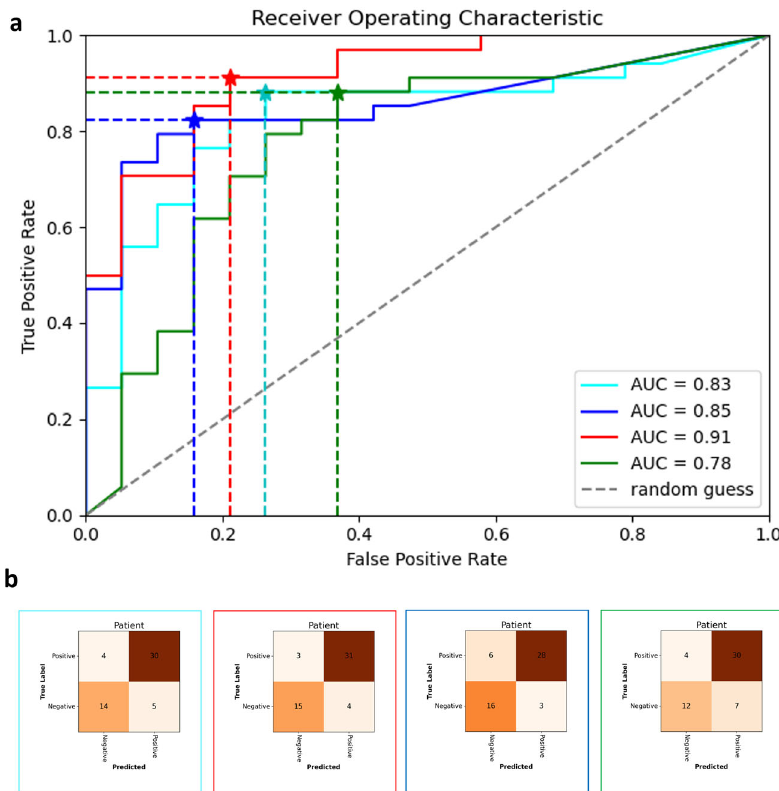
Fig. 3 Evaluation results for ESV1 on patient level. Receiver operator characteristics on EVS1 resulting from fourfold cross validation ( a ). Confusion matrices are shown in ( b ) for the optimal threshold (* in ( a )) in each fold. Frame colours in ( b ) correspond to ROC fold colours in ( a )). Vessel status is extracted automatically from 53 patients in EVS1 through the combination of fold-speci fi c groin and knee model